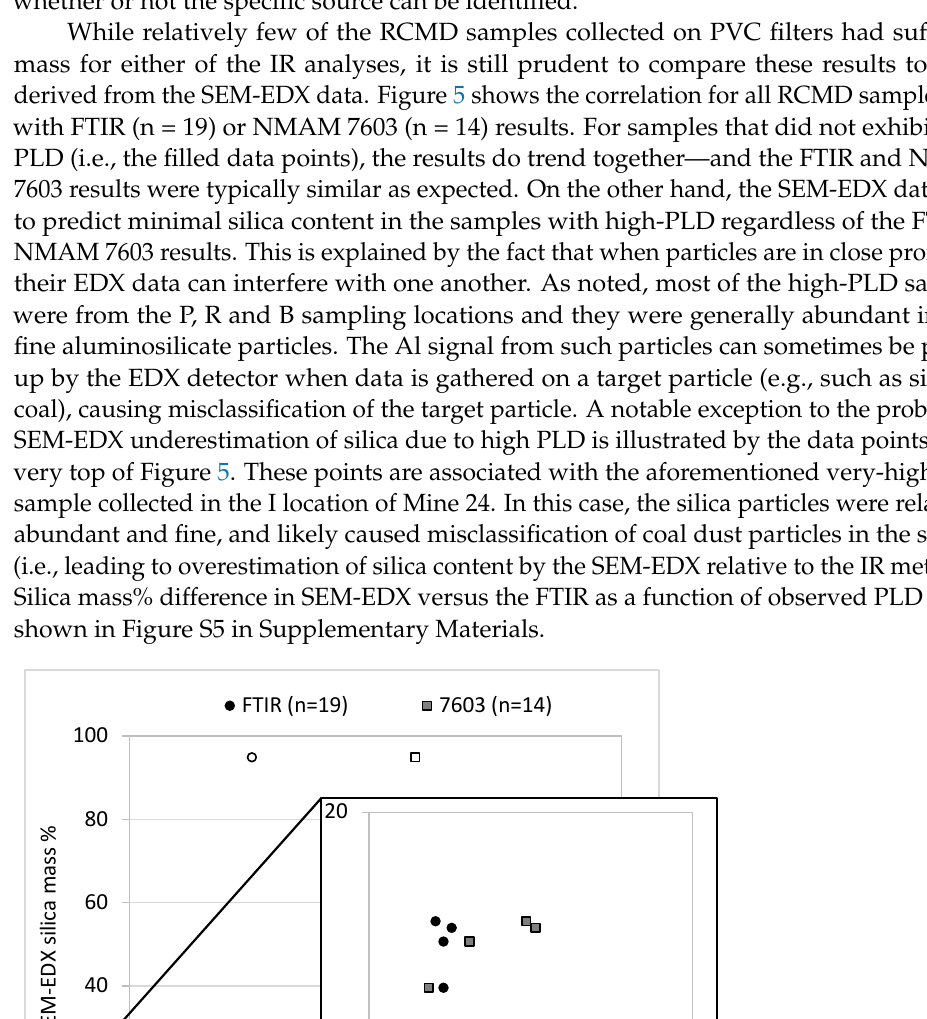
Figure 5. Correlation between the silica mass% estimate from SEM-EDX and quartz% measured by FTIR or NMAM 7603 for the RCMD sample pairs. Filled points indicate an observed PLD < 0.035 particles/µm 2 ; open points indicate a greater PLD. The data cluster in the lower left of the plot is magnified to visualize the effect of PLD on the SEM-EDX estimation of silica%.